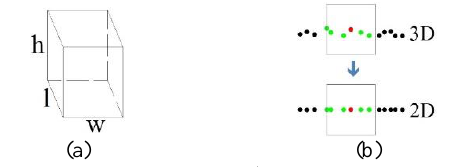
Figure 3 . Density-based method. a) The used cube dimensions to detect the neighborhood of each point, b) detecting the point neighborhood in 3D and 2D space. The red and green points represent the interest points and the points inside the cube, respectively.